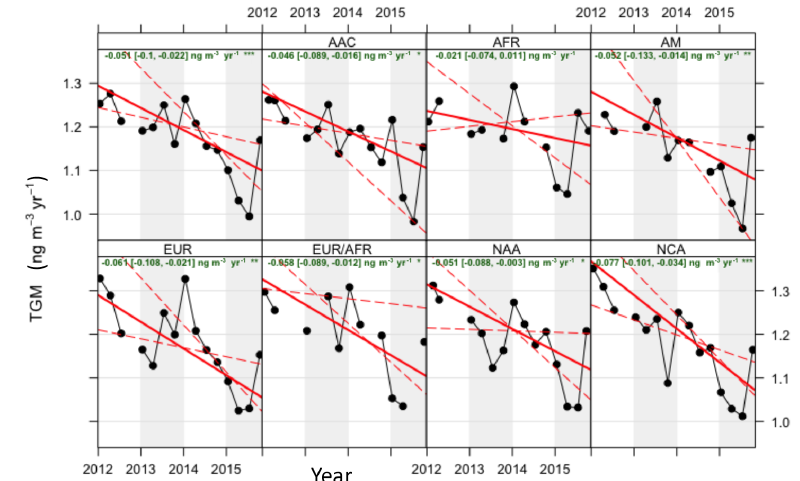
Figure 10. 4-year TGM trends using a Theil–Sen function based on seasonal TGM medians separated by air mass. The data for all air masses are shown in the top left panel with the rest of the panels showing the data separated by the seven air mass classifications. The green text shows the slope estimate and the 95% confidence intervals are in brackets. In each case the solid red line shows the trend estimate and the dashed red lines show the 95% confidence intervals for the trend based on resampling